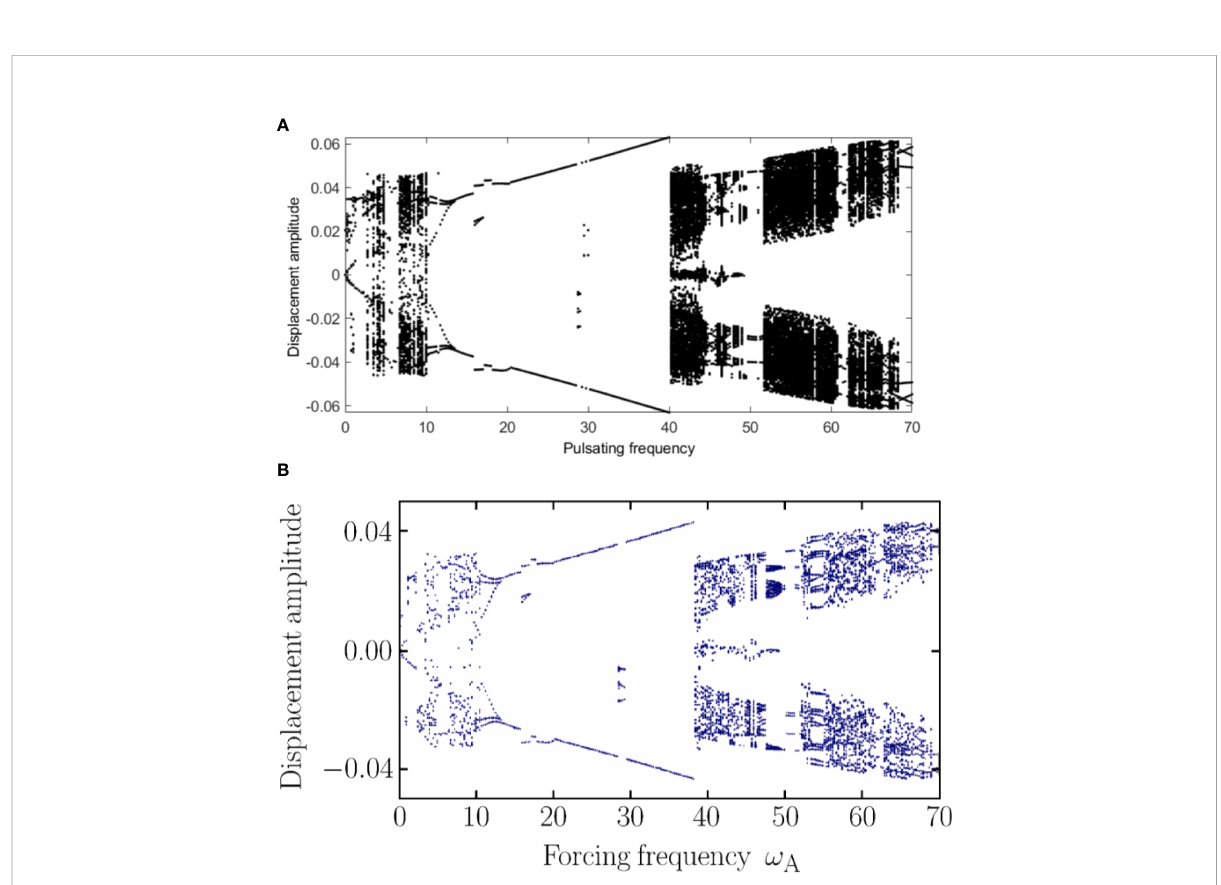
FIGURE 4 The bifurcation diagrams for the midpoint of the pipe with static supports: (A) the present work; (B) Figure 2 in the work of Ni et al.